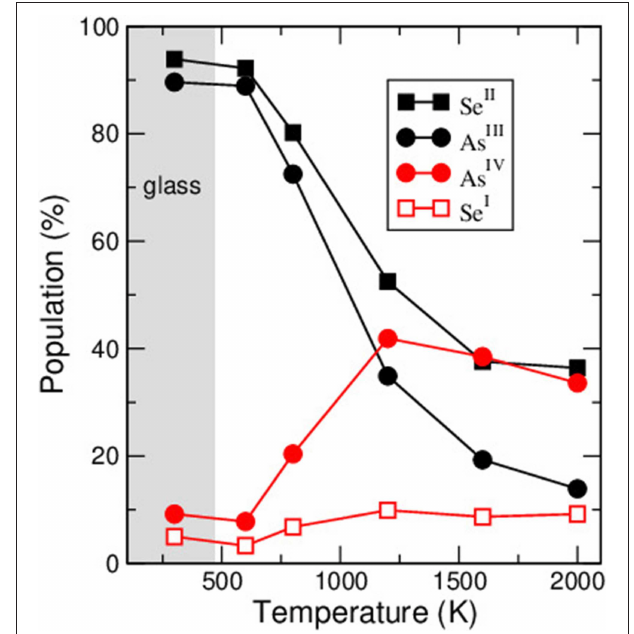
FIGURE 5 | Calculated fraction of r -fold species in amorphous and liquid As 2 Se 3 (after Micoulaut and Bauchy, 2013). The gray zone corresponds to the glass region with T g derived from Chen et al.